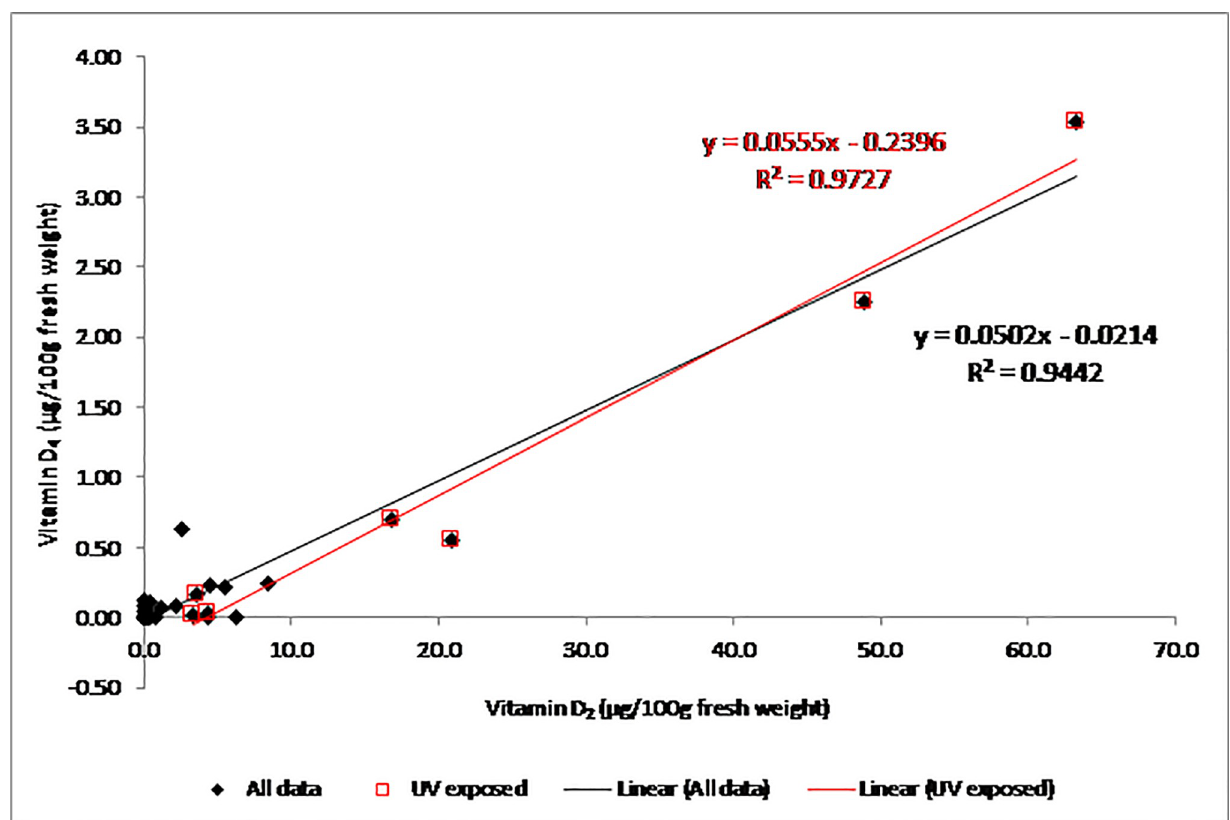
Fig 4. Relationship between the vitamin D4 and vitamin D2 concentrations in ten types of mushrooms (Table 1). Data for vitamin D2 were previously reported [14].